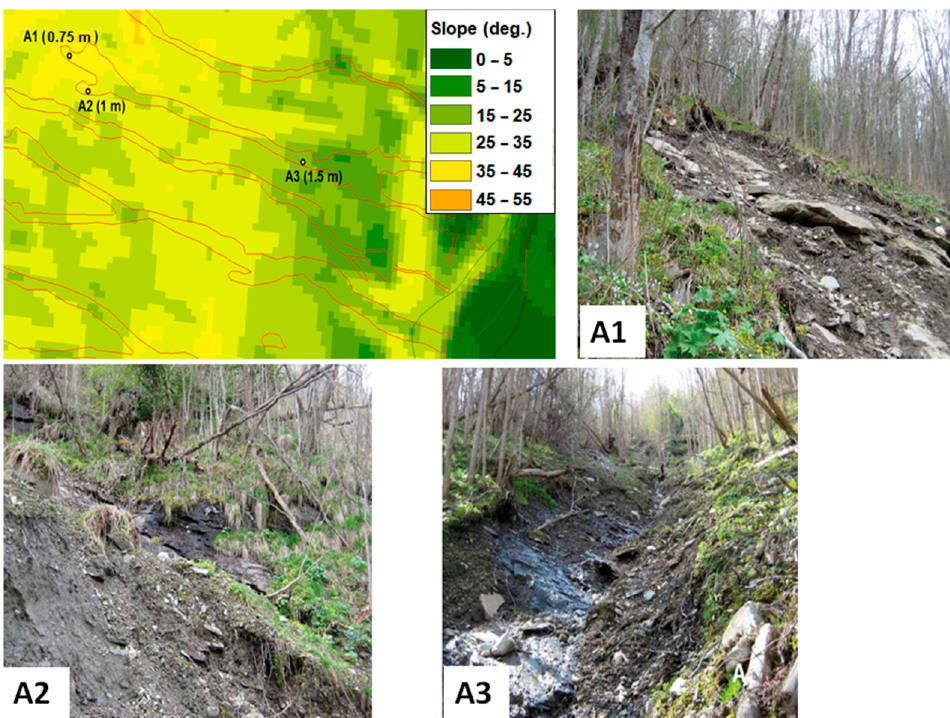
Figure 4. Pictures taken in three different points ( A1 , A2 and A3 ) where the thickness of the surficial cover and the GPS position were measured on field. The locations of these points are reported in the upper left figure, together with the local spatial variation of slope angle (source: [29]).